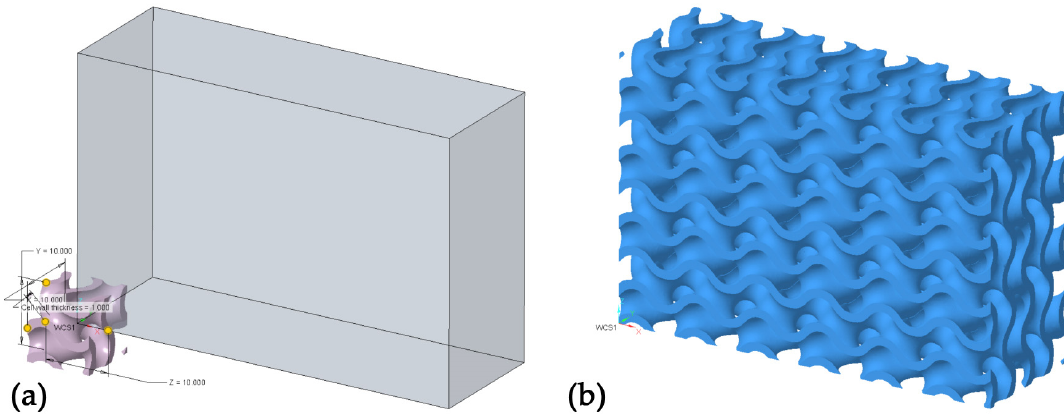
Figure 1. Designing the Gyroid structure in PTC Creo. ( a ) Graphic rendering during the creation of the Gyroid structure through the Lattice feature; ( b ) created Gyroid